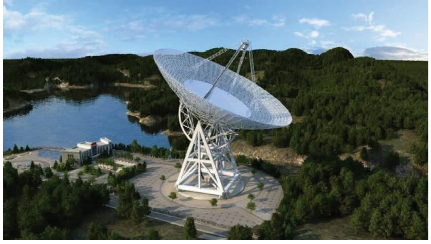
Figure 18: Design sketch of JRT (https://www.sohu.com/a/